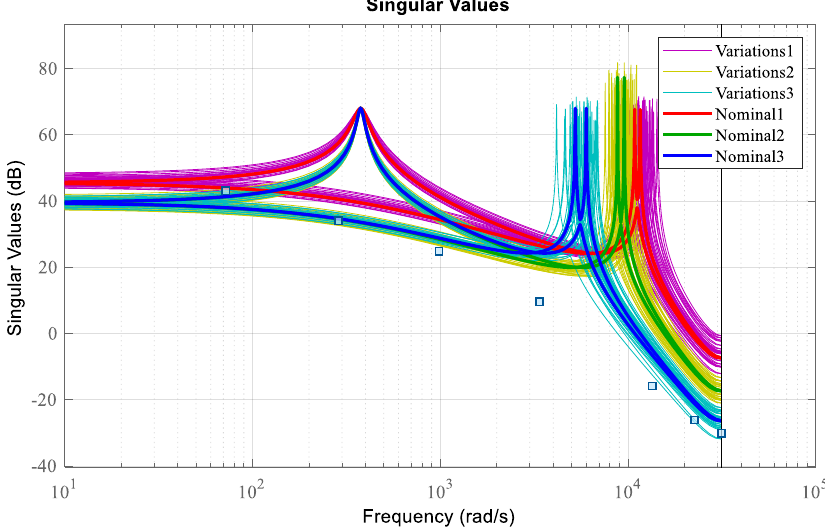
Figure 9. Eigenvalues of nominal G 1 ( z ) , G 2 ( z ) , and G 3 ( z ) and their variations.